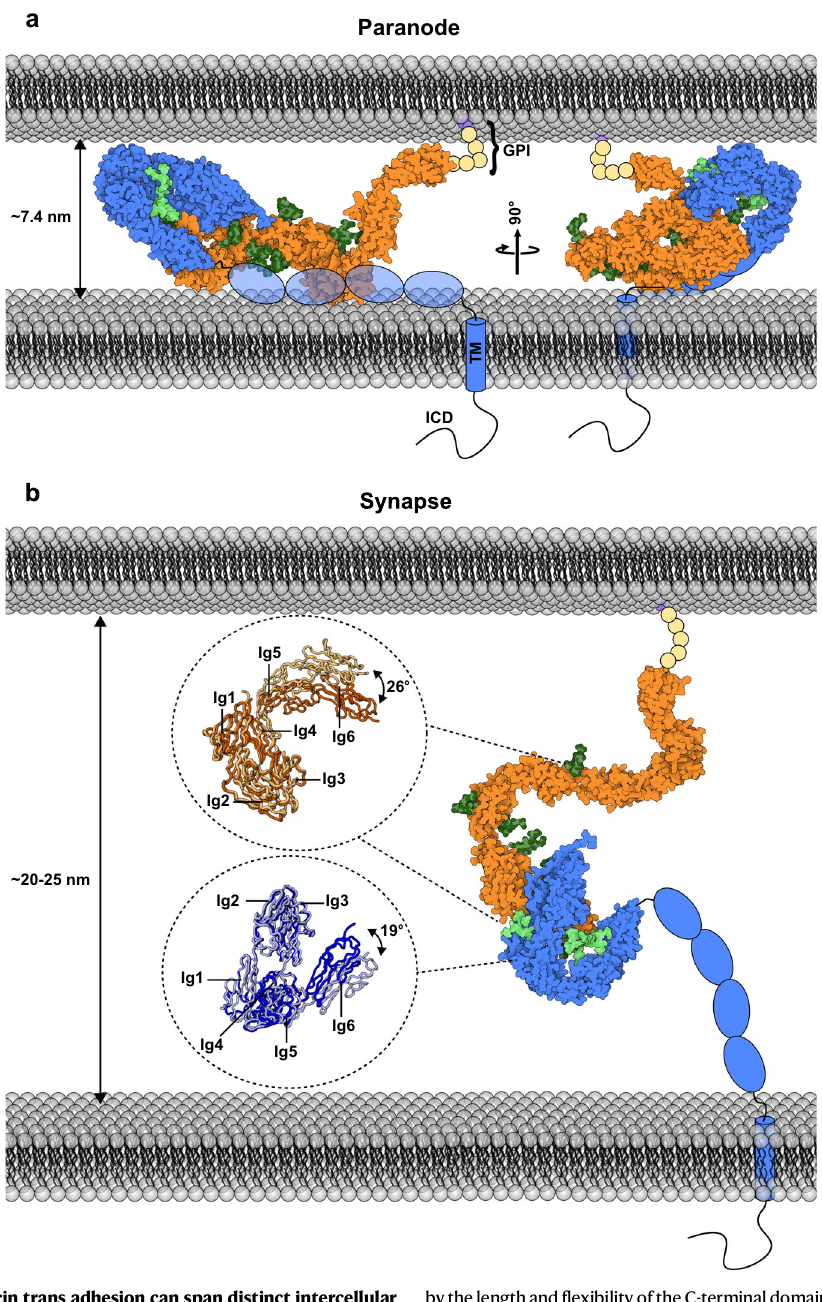
Fig. 6 | Contactin 1 – neurofascin trans adhesion can span distinct intercellular distances. a Model of the contactin 1 – neurofascin 155 complex in the ~7.4nm paranodal intermembrane spacing, with molecules laying fl at on the membranes and horseshoes determining minimum intermembrane distance. b Model of the contactin 1 – neurofascin complex spanning the ~20 – 25nm synaptic cleft,